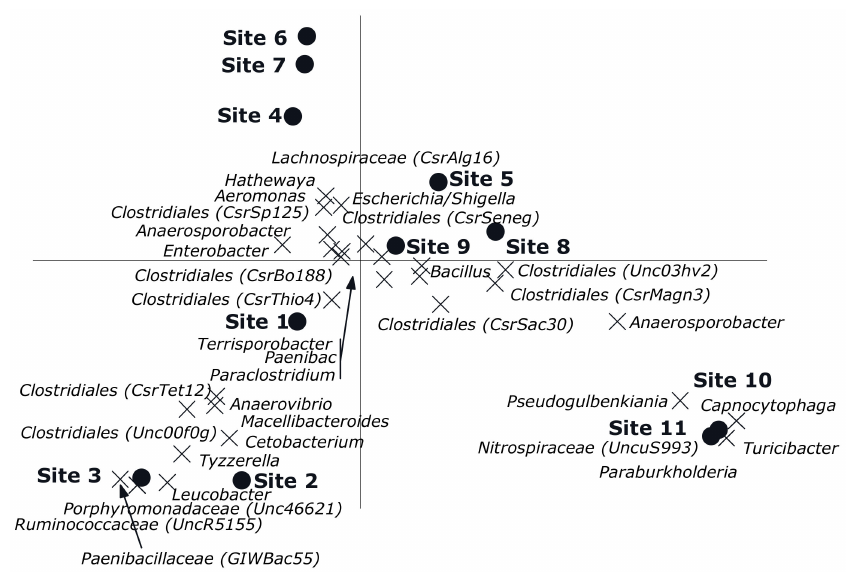
Figure 4. Canonical correspondence analysis biplot showing the results of the analysis using sites as explanatory variables and depth and being aerobic or anaerobic as covariables. Of all variance, 38% was explained by the di ff erences between sites while the covariables explained 15% of the variation in genus composition. Of the variation explained by sites, 33% is displayed on the horizontal axis and an additional 18% on the vertical one. Only the 33 genera of which more than 15% of its variation is displayed by the axes are shown. Sites 1–4 (Unexposed area, sites from the water source upstream); Sites 5–9 (Exposed area, rice field where the pesticides are applied); Sites 10–11 (Residual area, sites downstream of the irrigation line).